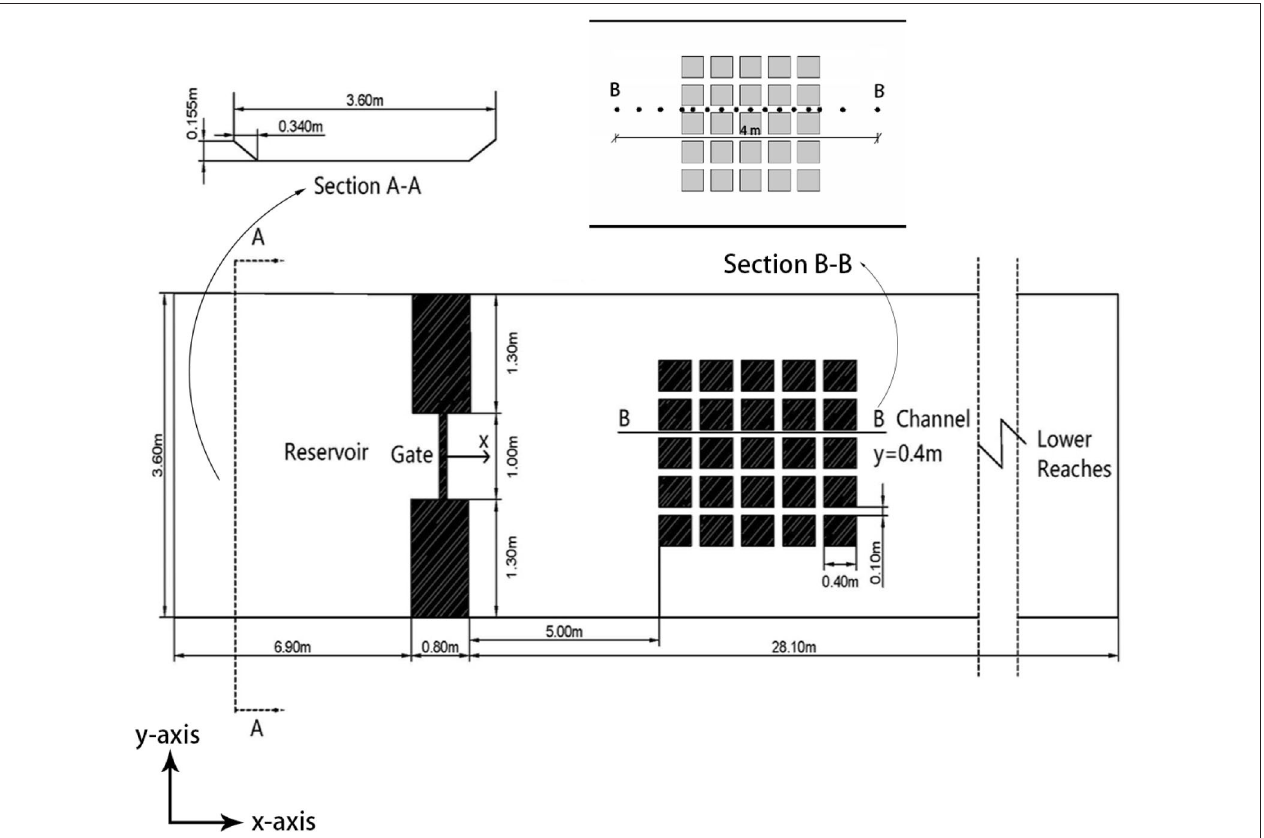
FIGURE 1 | Parameters and setting of numerical simulations after (Yu et al., 2019).